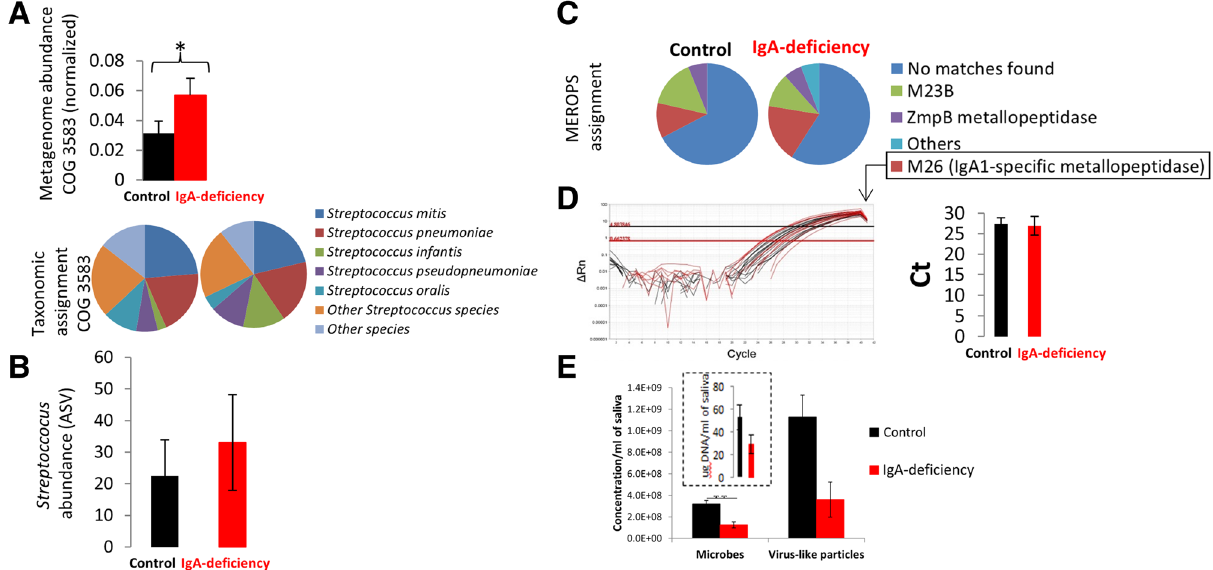
Figure 2. Metagenomic analysis and microbial and viral abundance in controls and IgA deficiency. ( A ) Metagenomic analysis of abundance of genes annotated within COG 3583 involved in the processing and cleavage of IgA (bar chart). An over enrichment is observed from IgA deficiency patients. Taxonomic assignment of bacteria having COG3583 (pie chart) that was clearly dominated by Streptococcus spp. ( B ) Relative abundance of amplicon sequence variants (ASV) assigned to genus Streptococcus. Although more Streptococcus was found in IgA deficiency samples, differences were not statistically significant. ( C ) Analysis of